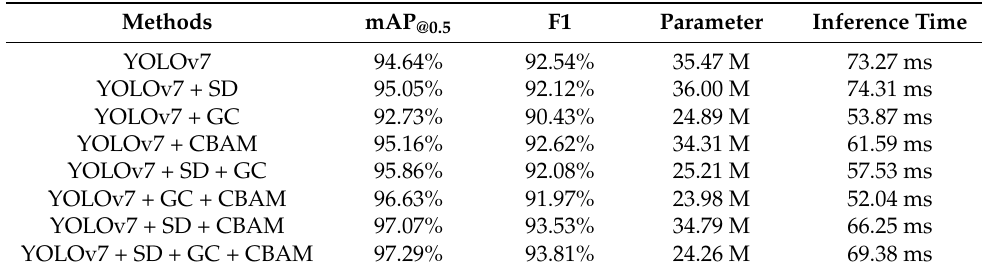
Table 4. Ablation experiments of